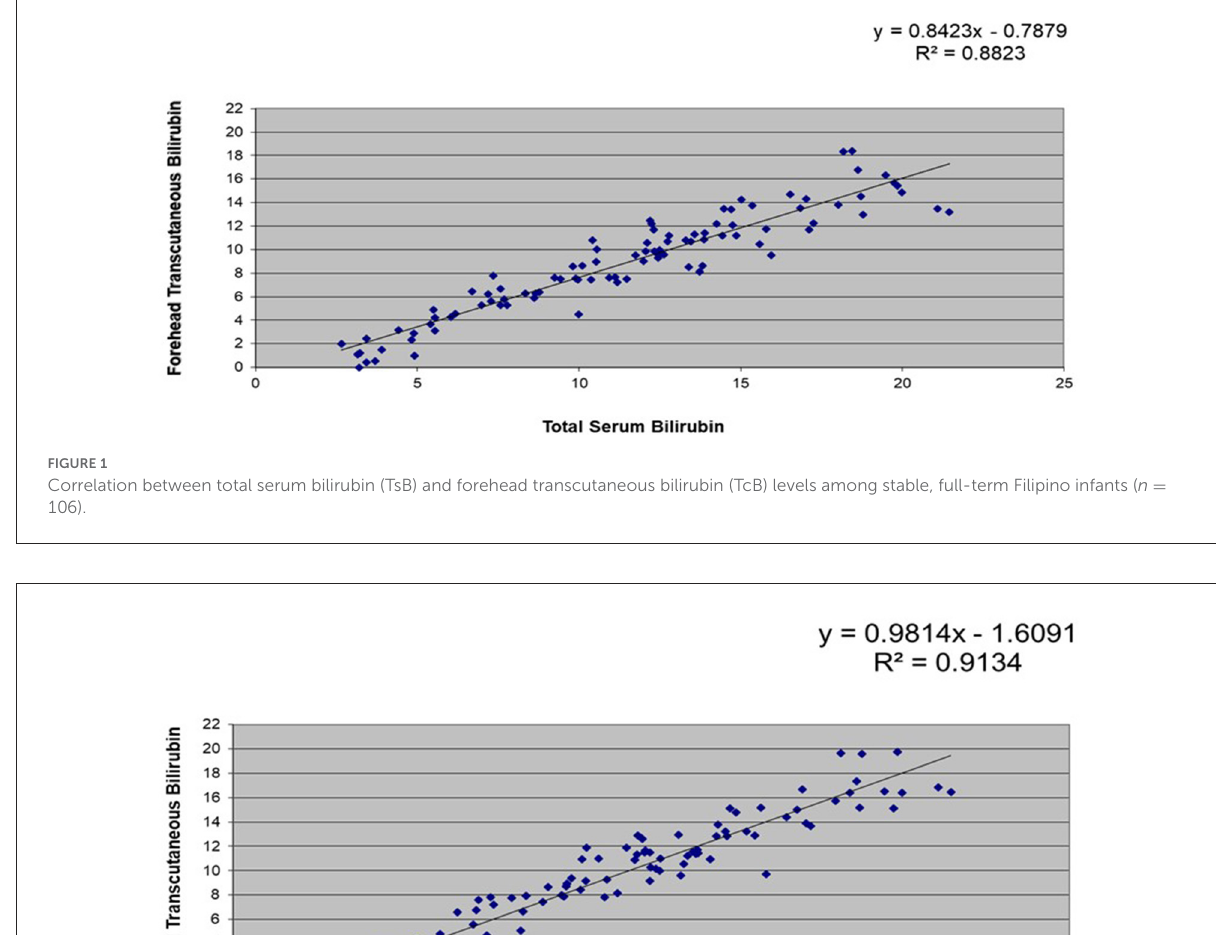
Determination of the cut-off for the low-risk